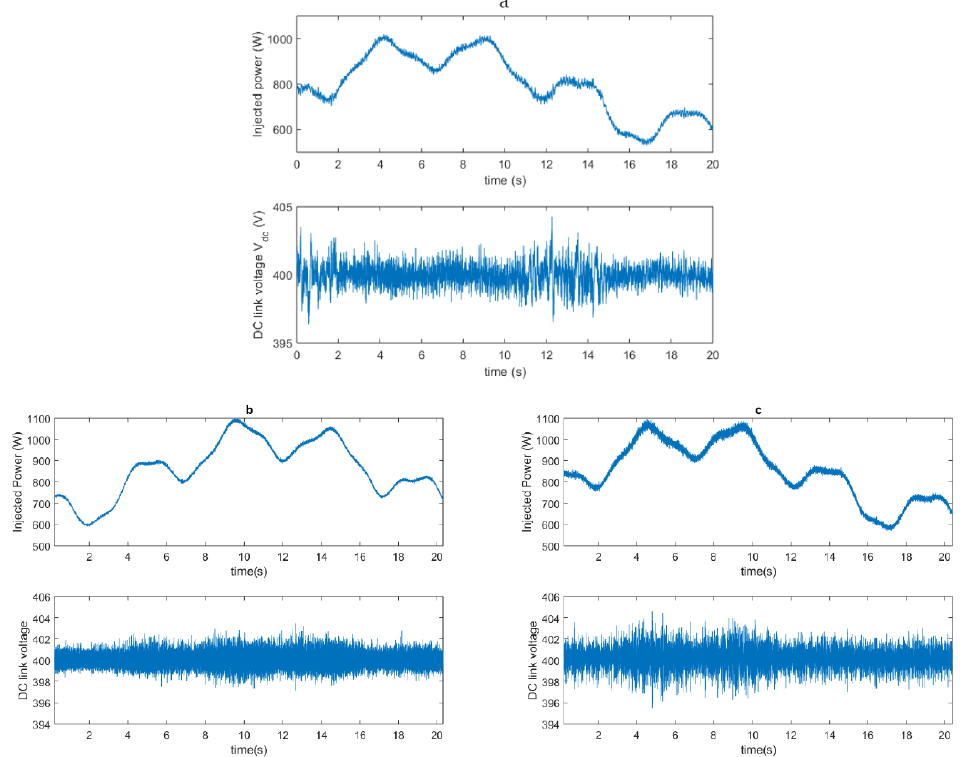
Figure 10. Responses of the grid-side converter in the variable regime with the ( a ) linear controller, ( b ) SMC1 controller; and ( c ) SMC2 controller for C = 30 µ